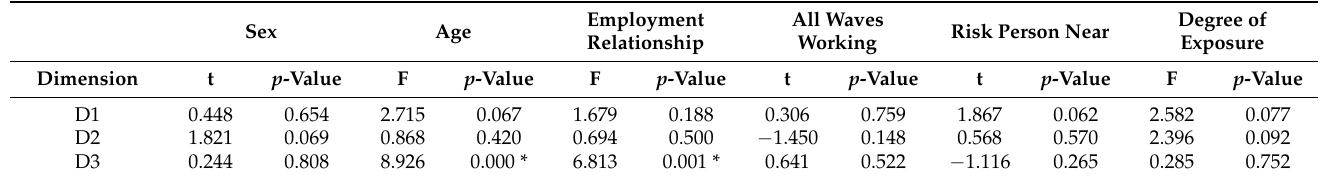
Table 5. Results of mean comparation tests between dimensions and covariate